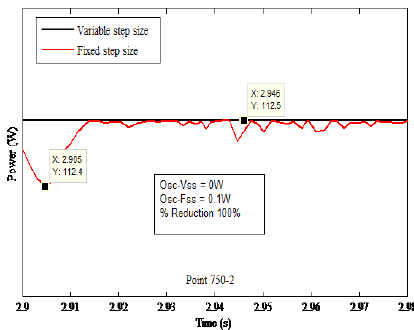
Fig. 10: Output power: Zoom in Point 1000-1.